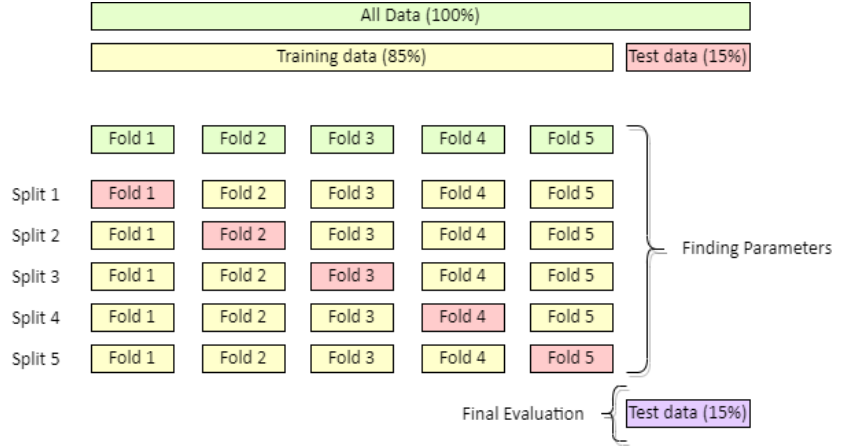
Figure 2. Scheme of the K-fold cross-validation for the proposed ML models, inspired from [47,48].